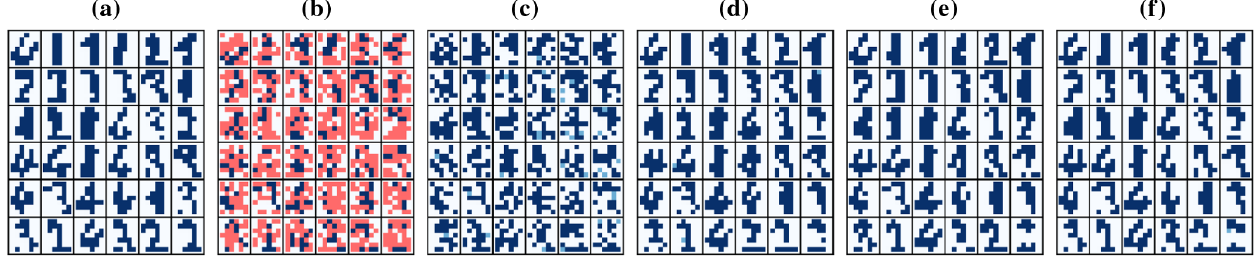
FIG. 4. OptDigits experiment. (a) We show 36 samples from the test set, with each pixel being either dark blue ( þ 1 ) or white ( − 1 ). See Fig. 3 and the main text for a description of the preprocessing steps. (b) A uniform salt-and-pepper noise shown in red corrupts each picture. The model cannot use information from the red area. (c) – (f) Reconstructions obtained after 1, 10, 1000, and 6000 learning iterations. A light blue pixel indicates a tie of the majority vote over the corresponding subgraph. We can visually verify that the model has learned to generate digits. The learning stops at iteration 6000 because further iterations would bring some parameters out of the dynamic range of the DW2X device.